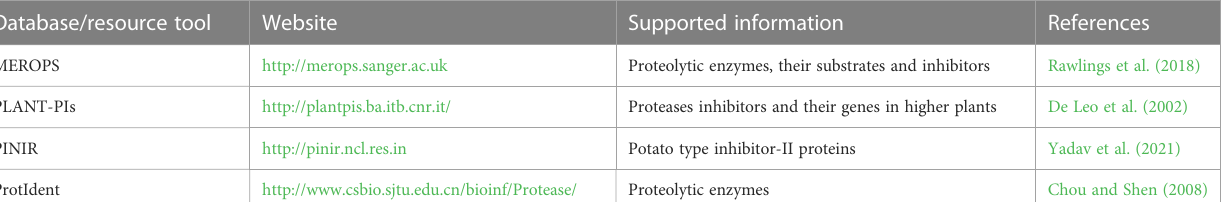
TABLE 1 Online databases and resource tools for plant proteases and protease